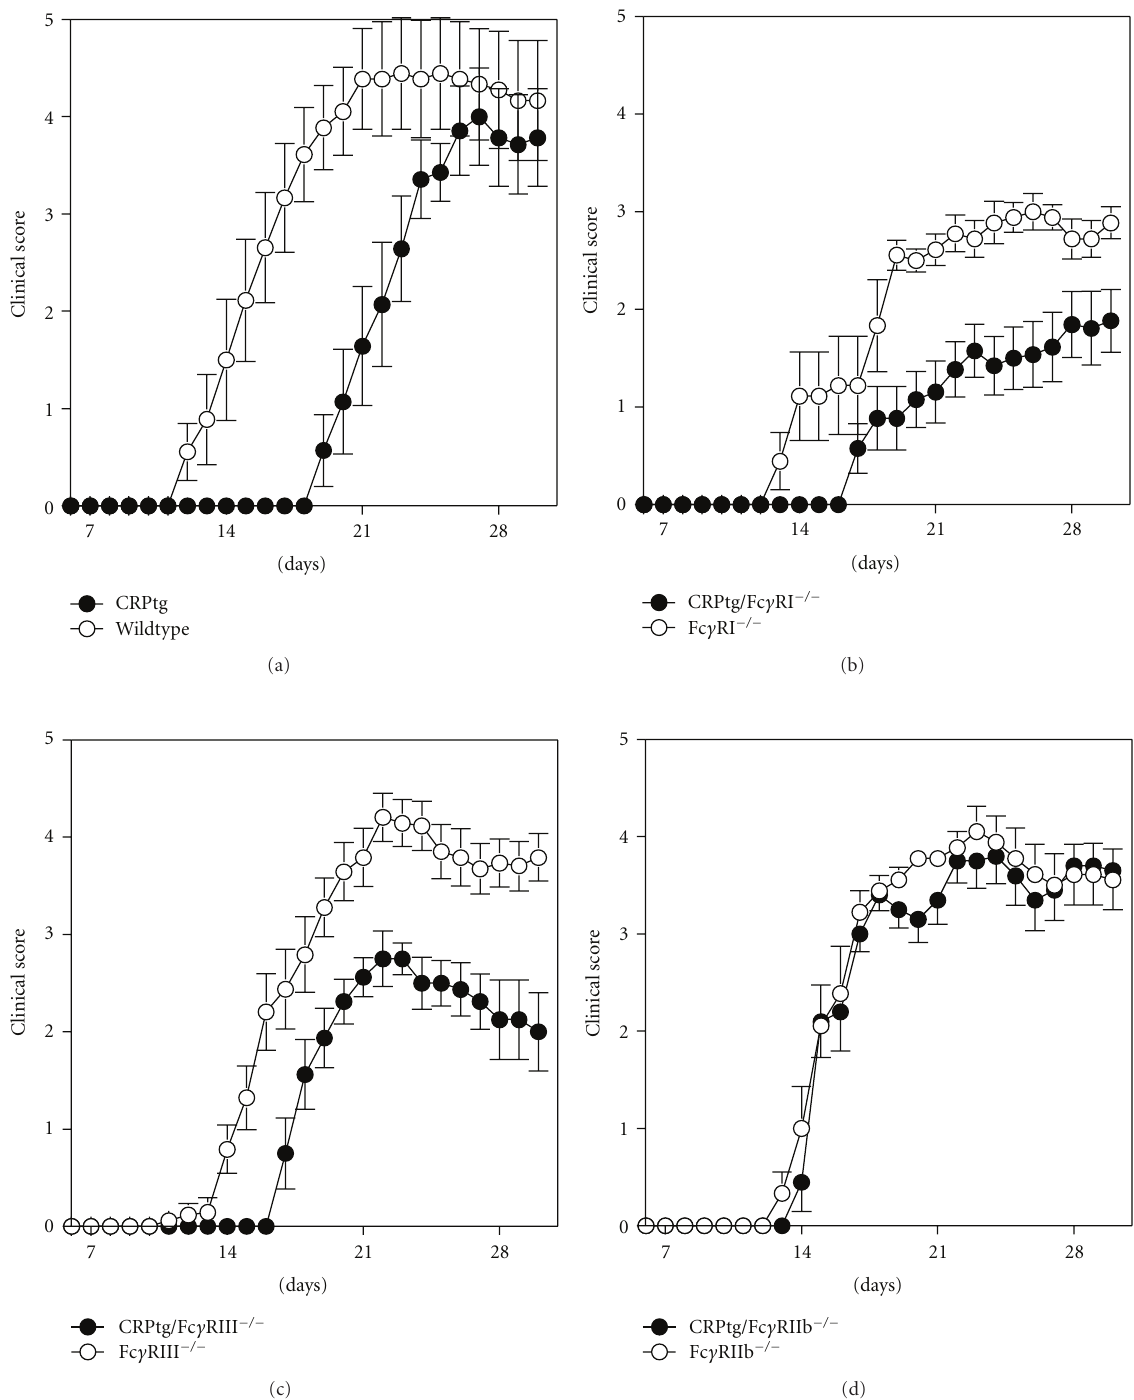
Figure 2: CRP-mediated protection from EAE requires Fc γ RIIB. CRPtg versus littermate wildtype (a) or their respective counterparts lacking expression of Fc γ RI (b), Fc γ RIII (c), or Fc γ RIIB (d) were injected with MOG peptide, and EAE symptoms were monitored. Presence of the CRP transgene (closed circles in each panel) delayed onset of EAE in mice with intact Fc γ Rs (a) and delayed onset and reduced severity of EAE in mice lacking Fc γ RI (b) or Fc γ RIII (c). In contrast in mice lacking Fc γ RIIB (d), expression of human CRP had no beneficial e ff ect. See Table 1 for sample sizes and statistical